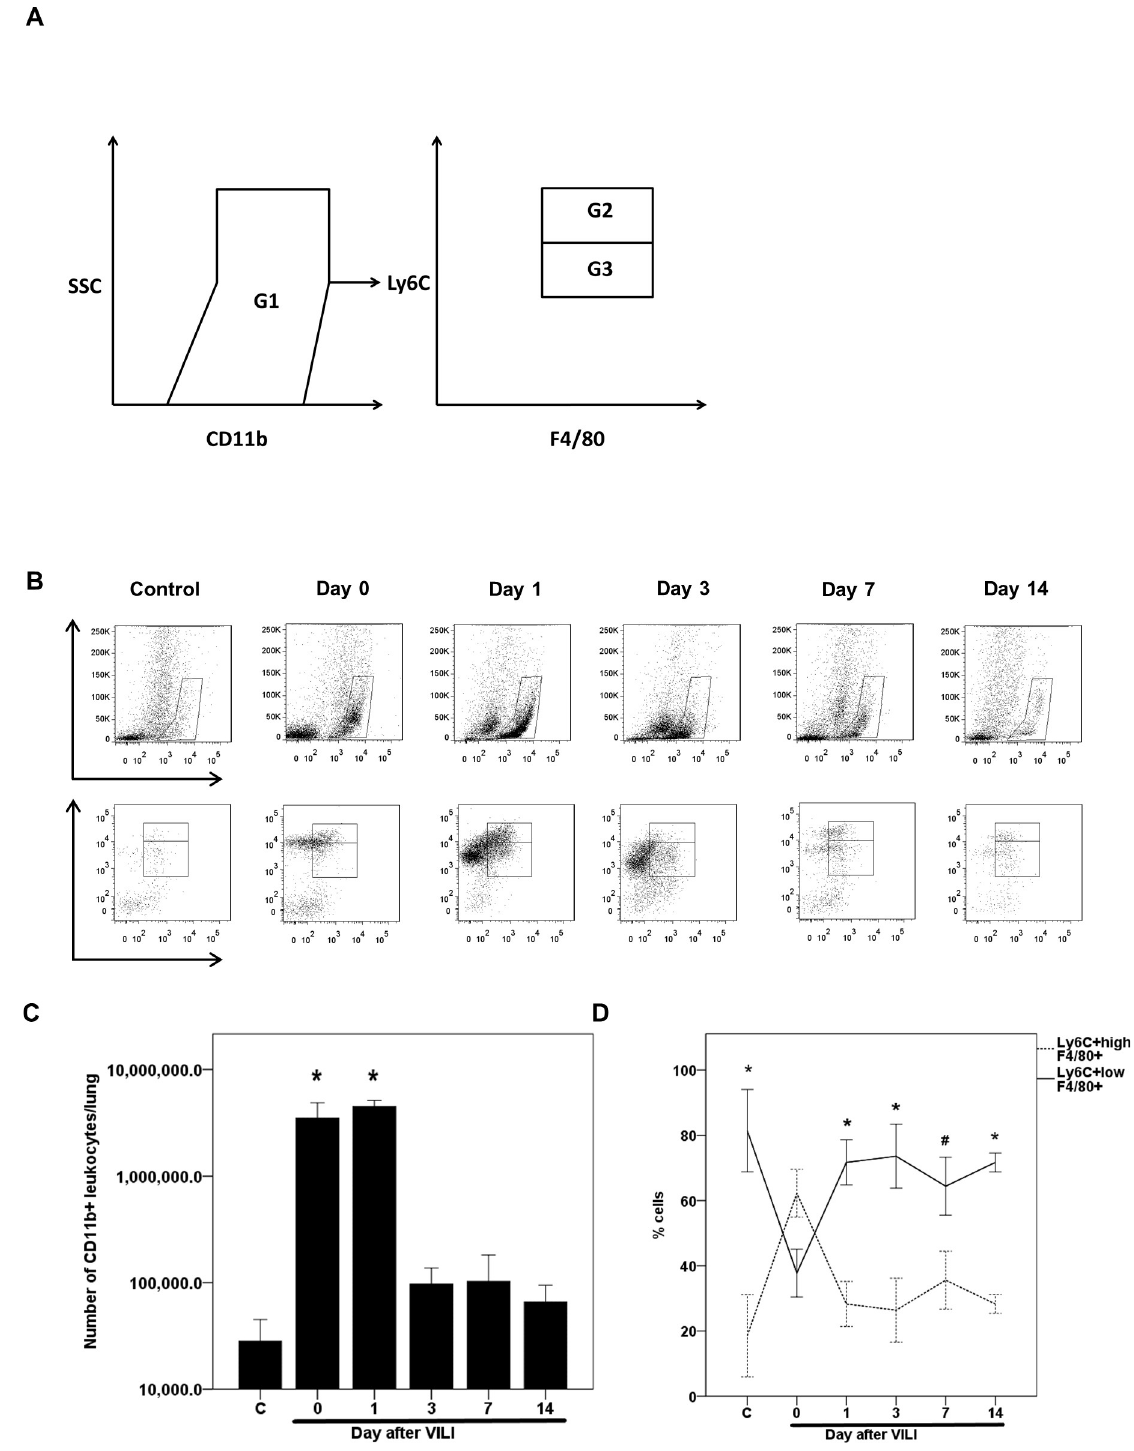
Fig 2. Phenotype and time course of post-VILI levels of lung-recruited monocytes as determined from flow cytometric analysis. (A) Gating strategy for differentiating CD11b + leukocytes and Ly6C + monocyte subsets. CD11b + population (G1) was gated for estimation of lung-recruited leukocytes (neutrophils and monocytes). In the G1 population, the F4/80 positive population, which represented monocytes, was gated further and divided into the Ly6C +high (G2) and the Ly6C +low (G3) population. (B) The time course of lung-recruited leukocytes and the Ly6C phenotypic change of lung-recruited monocytes immediately after VILI (day 0) or on days 1, 3, 7, and 14 after VILI. (C)